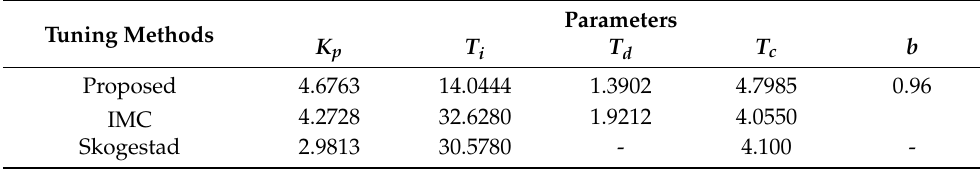
Table 2. Parameter tuning for PID